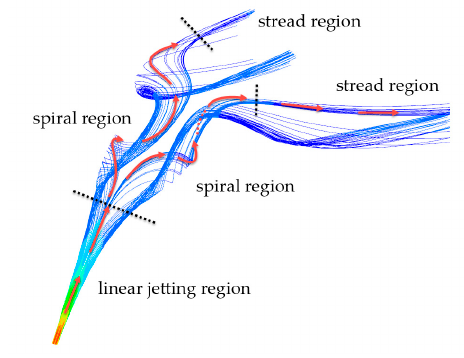
Figure 6. 3D structure of the jet streamtrace.